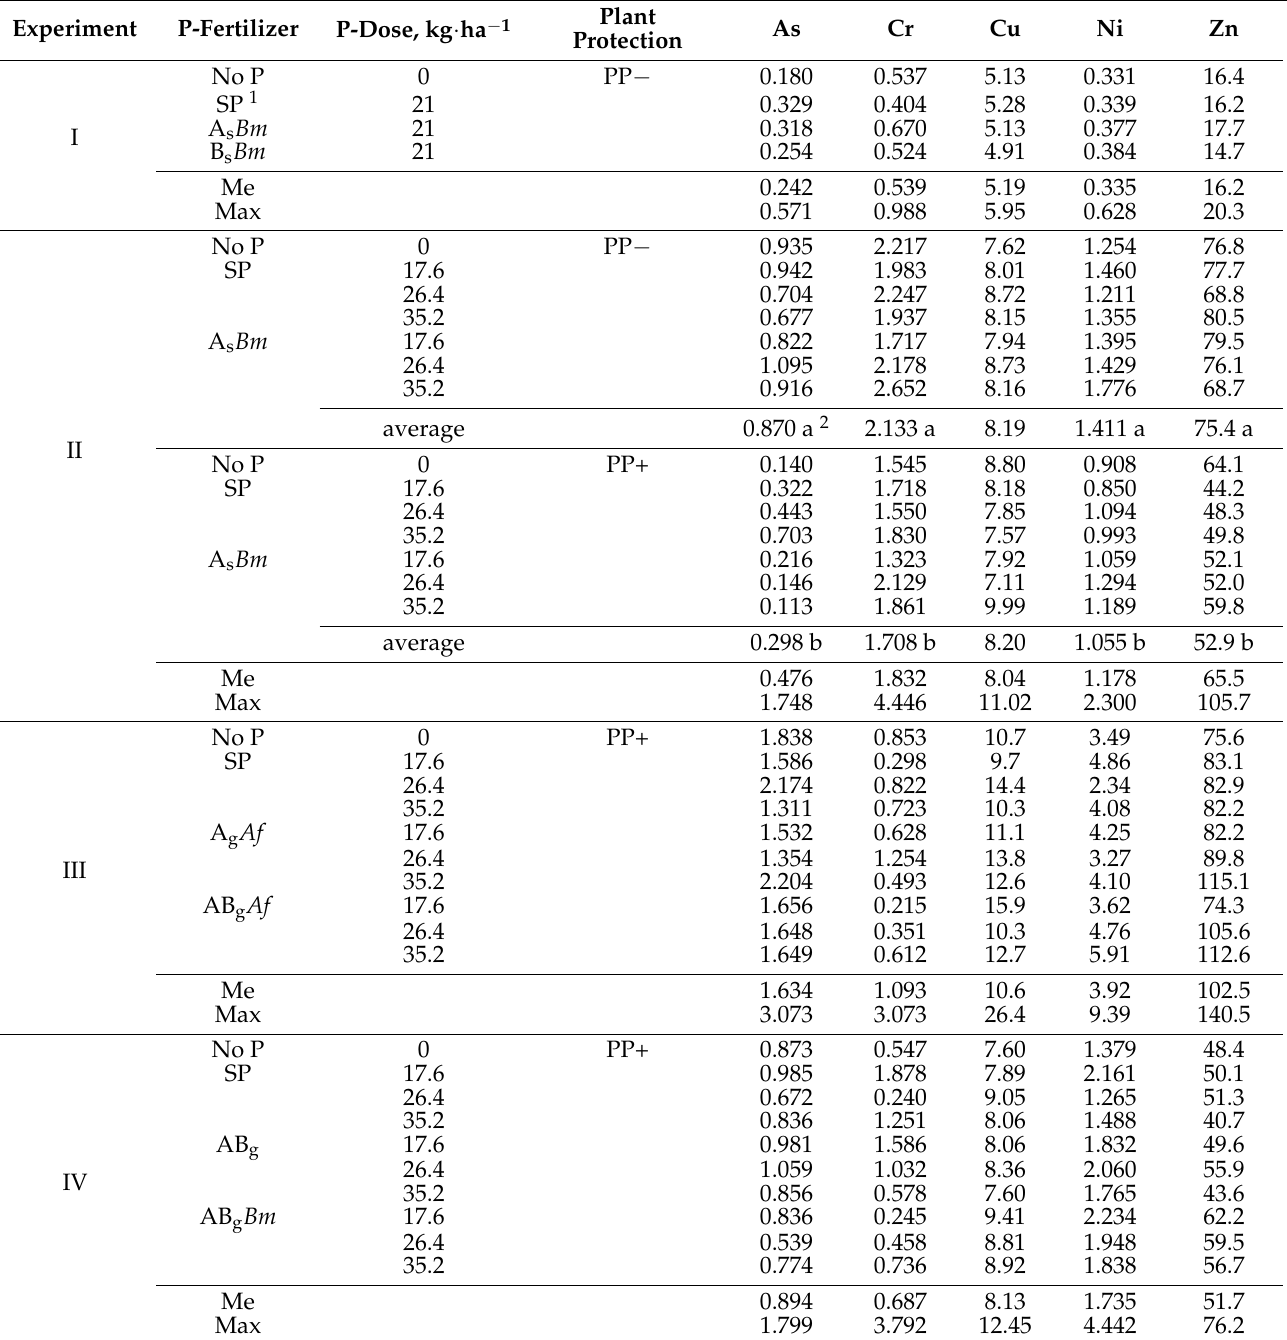
Table 13. PTE content in weeds, mg · kg − 1 DM (n =